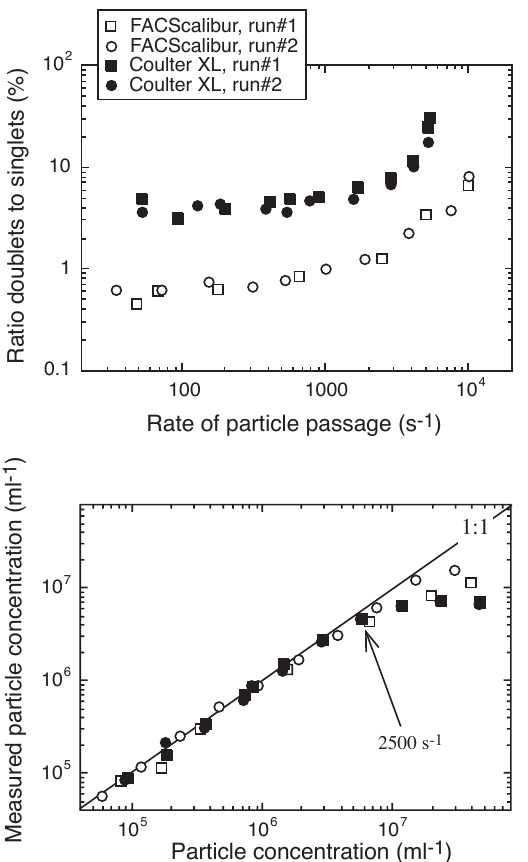
F IG . 4. – Effects of the speed of particle passage through two dif- ferent flow cytometers (Coulter XL and Becton and Dickinson’s FACScalibur). The speed was changed by serially diluting a fluo- rescent bead solution: Upper panel, the amount of beads detected as doublets. Lower panels, relationship between the actual particle concentration and the flow cytometrically measured particle